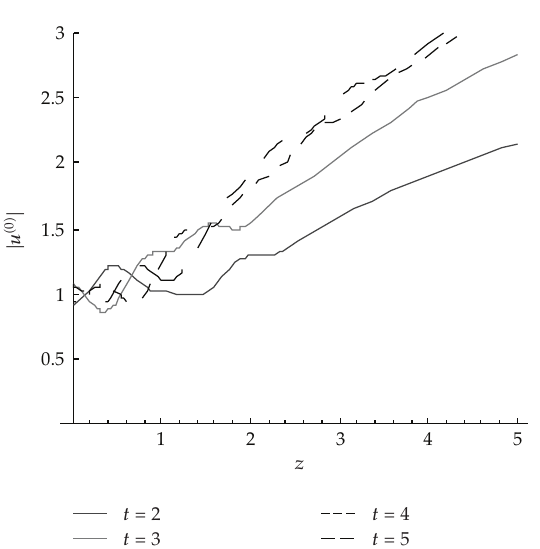
Figure 15: The zero-order approximation | u (cid:3) 0 (cid:4) | at α (cid:8) 1, T (cid:8) 10, γ (cid:8) 02 for di ff erent values of t , considering only one term in the series (cid:3) M (cid:8) 1 (cid:4) .